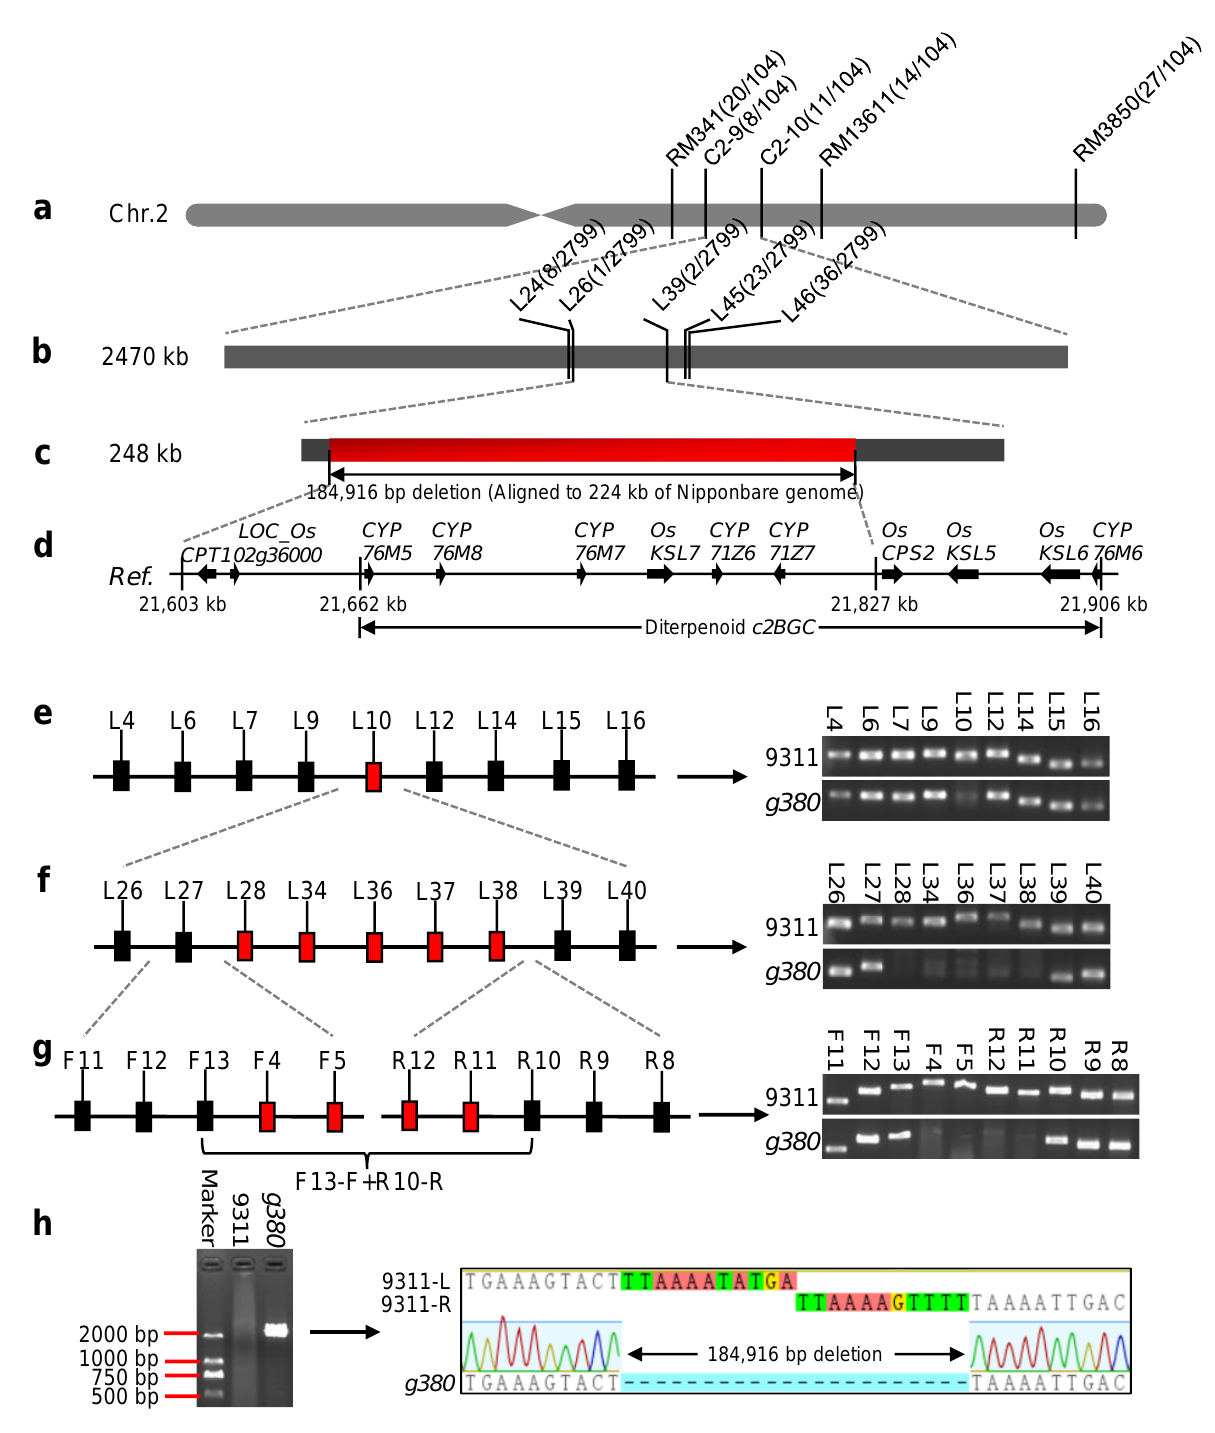
Figure 2. Fine mapping of g380 . ( a , b ) Preliminary mapping interval. ( c ) Fine mapping interval; red area represents the deletion fragment. ( d ) Reference genes in the deletion area. ( e – g ) Process to determine the deletion area in g380 ; general view of the process is on the left, and the results of agarose gel electrophoresis are on the right. ( h ) Results of 9311 and g380 amplified with F13 forward primer and R10 reverse primer; the start and end sequences of the deleted fragments were obtained by sequencing. Red boxes in ( e – g ) represent the deletion area or primers in the deletion area. Using chromosome walking, we found that the amplicon with primer L10 could not be formed from the recessive g380 phenotypic plants, which indicates a fragment deletion at the L10 site in g380 (Figure 2e). To confirm the deletion range, ten new primers sur- rounding L10 (5 kb upstream and 5 kb downstream) were used to amplify 9311 and g380 . All ten primers failed to obtain amplicons from g380 but succeeded with 9311 (data not shown), suggesting a large fragment deletion in g380 . Additional primers were used to expand the analysis range, leading to identification of the left end of the deletion site be- tween L27 and L28 and the right end of the deletion site between L38 and L39 (Figure 2f). Finally, the deletion site was narrowed to the ranges between F13 and F4 (left), R11 and R10 (right) (Figure 2g). Then, we performed PCR with the forward primer F13 and reverse